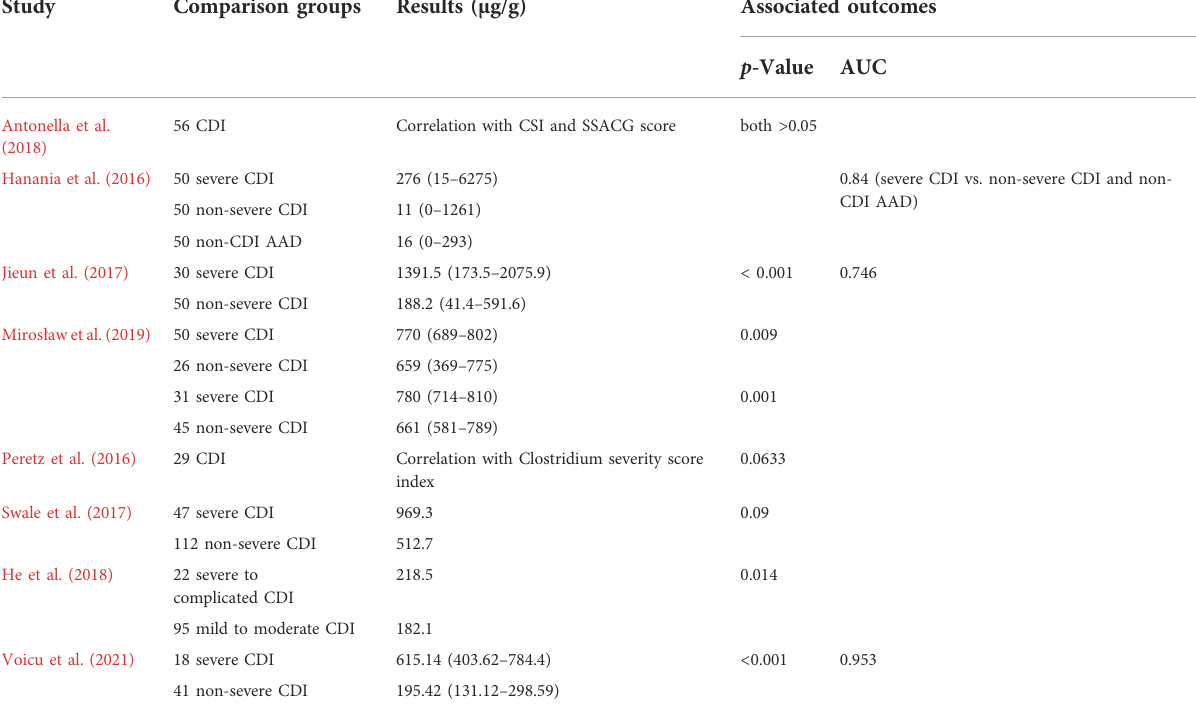
TABLE 5 Main results of studies that explored the relationship between fCP and the severity of CDI.